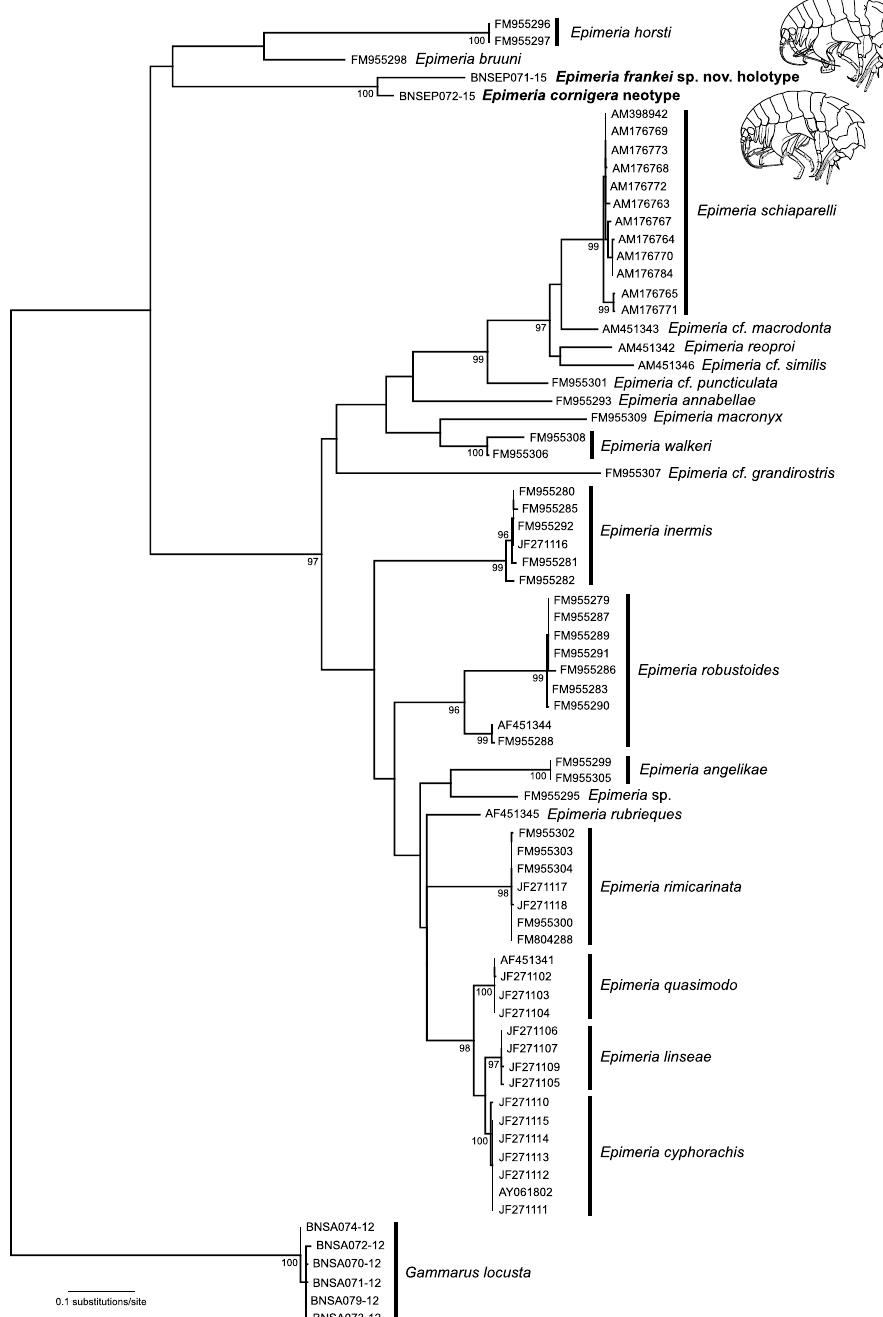
Figure 2. Maximum Likelihood phylogenetic tree of the partial COI sequence data set of 19 Epimeria species and Gammarus locusta as outgroup. Model of choice: HKY with a log likelihood score of − 6124.0843, a discrete gamma distribution ( + G, parameter = 1.0064) and a proportion of invariant sites ( + I, 46% of sites). Numbers next to internal branches are non-parametric bootstrap values (in %). Only values above 90% are shown. Initial tree(s) for the heuristic search were obtained automatically by applying BioNJ algorithms to a matrix of pairwise distances estimated using the Maximum Composite Likelihood (MCL) approach, and then by selecting the topology with superior log likelihood value. The tree is drawn to scale with branch lengths measured in substitutions per site. All positions with less than 95% site coverage were eliminated. That is, fewer than 5% alignment gaps, missing data, and ambiguous bases were allowed at any position. There were a total of 542 positions in the final